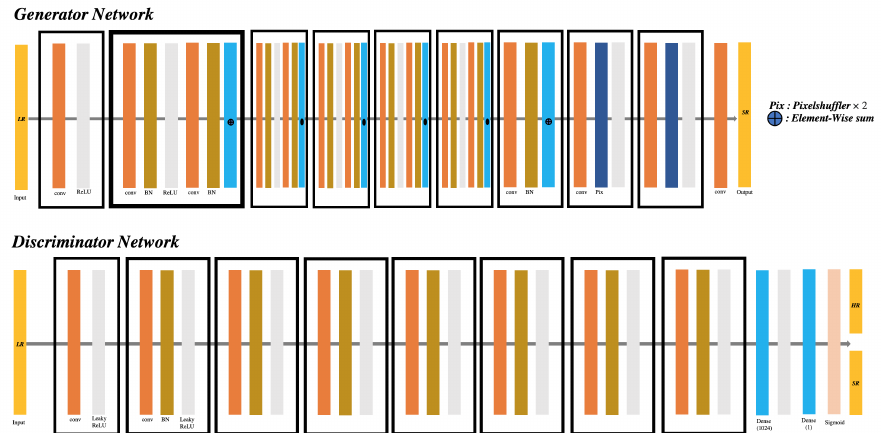
Figure 4. Architecture of SRGAN: The SRGAN structure consists of a Discriminator model and a Generator model. Each of them have own kernel size and number of feature maps and strides